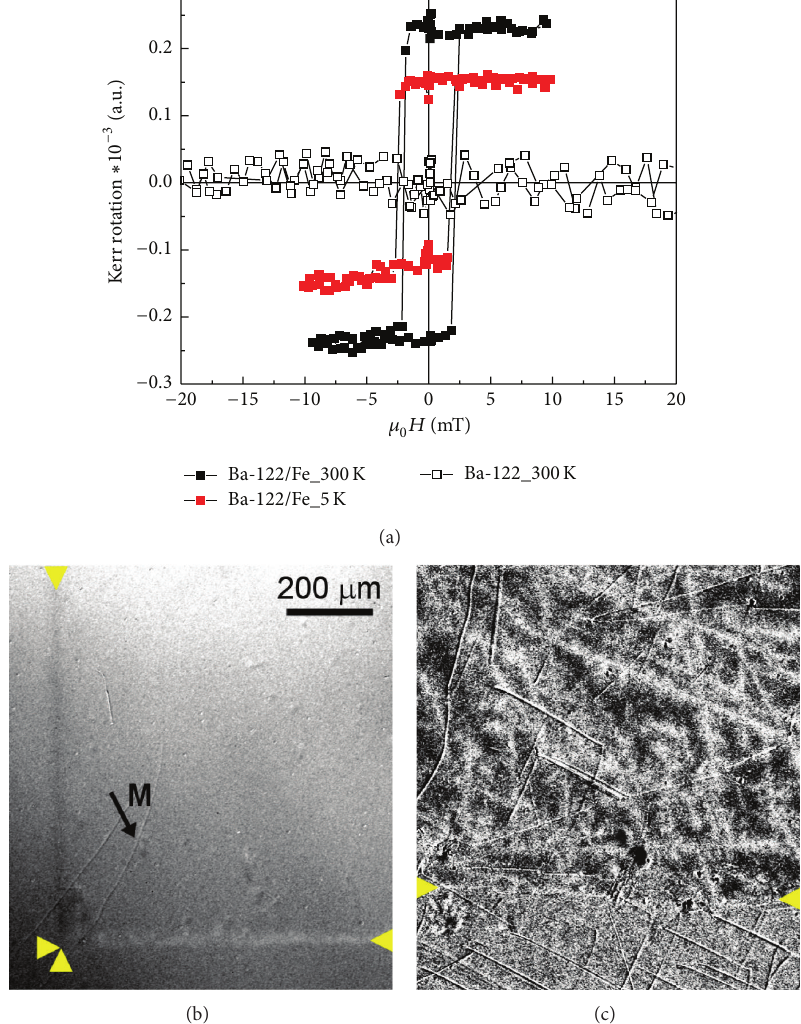
Figure 3: (a) Hysteresis loops obtained by means of MOKE measurements: Ba-122/Fe at 5 K (red squares) and 300 K (black squares); Ba-122 thin film at 300 K (open squares); (b) MOI on Ba-122/Fe film at room temperature. Since MOI is sensitive to out-of-plane magnetic fields, the in-plane magnetization direction can be inferred from the signal at the edges (indicated by yellow arrows). (c) MOI at low temperature ( 𝑇 = 10 K), after Zero-Field Cooling (ZFC) with applied magnetic field 𝐻 = 1.5 mT; bright regions: preferential vortex penetration and normal zones; dark regions: screened